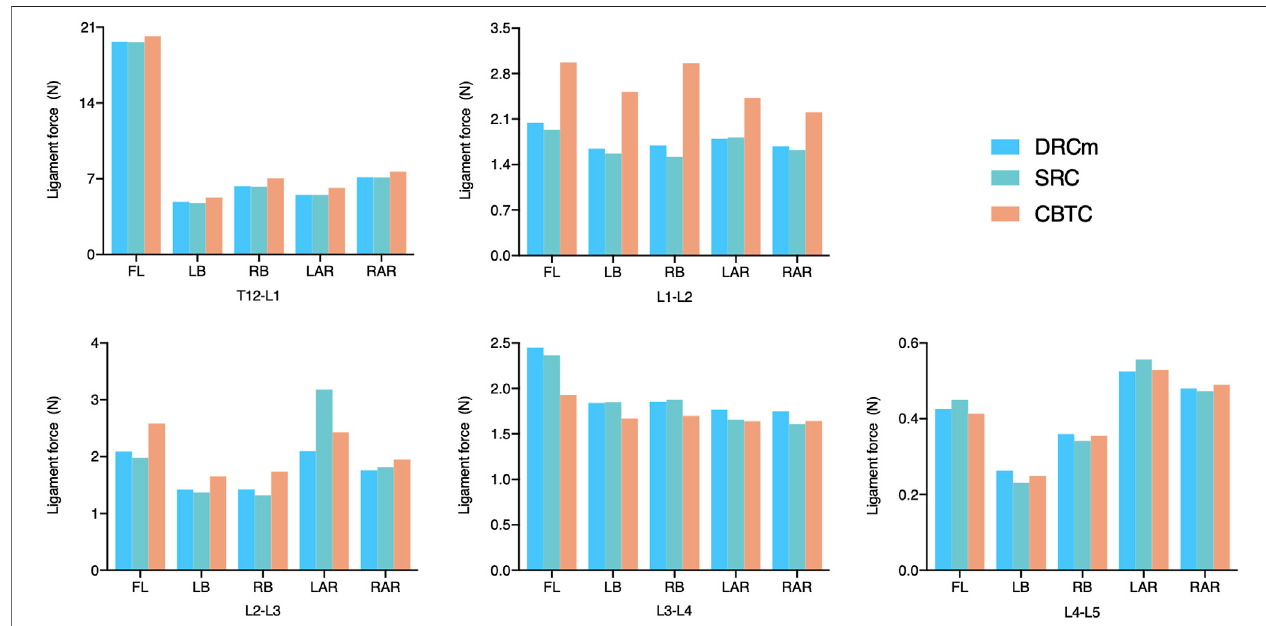
FIGURE 8 | Ligament force of FL in the loading direction of FL, LB, RB, LAR, and RAR after RS instrumentation using the DRCm, SRC, and CBTC.